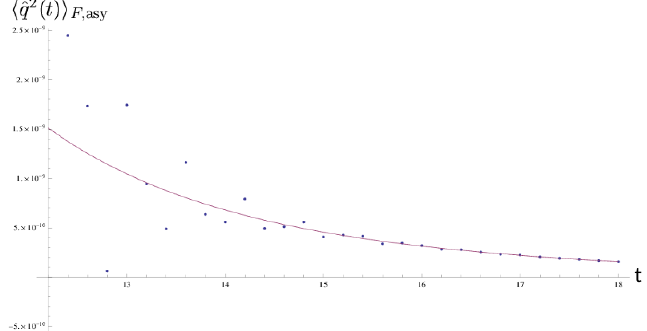
Figure 4 . The dots show the numerical calculation of h ^ q 2 ( t ) i F; asy , using the small ! approximate of G H in (3.11) and the G 2 ( ! ) in (5.6). The solid line shows the power law time dependence as we (cid:12)nd in eq. (5.15). In the plots, h ^ q 2 ( t ) i F; asy is in units of 2sin( (cid:11)(cid:25) )(cid:0)(1+ (cid:11) )sin( chosen as in (cid:12)gure 2 for narrow resonance.